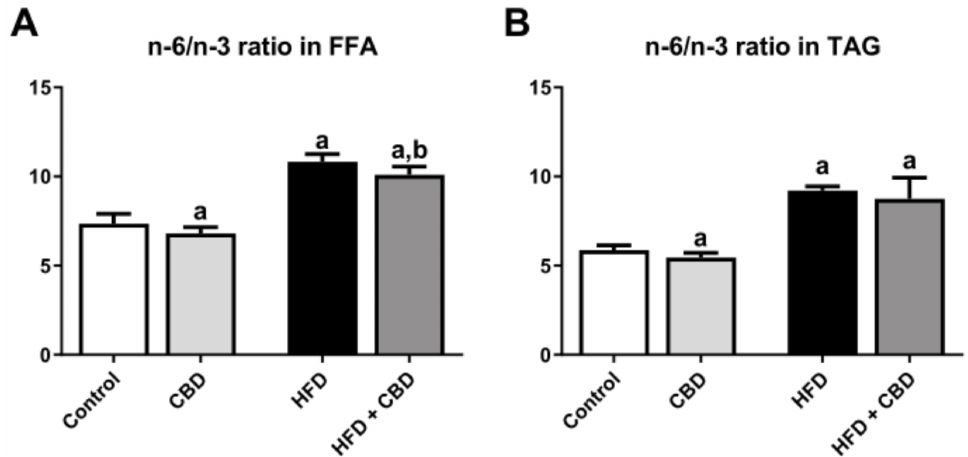
Figure 2. Plasma n-6/n-3 PUFA ratio in the ( A ) free fatty acid (FFA) and ( B ) triacylglycerol (TAG) fractions in the control (standard diet) and high-fat diet (HFD) groups after two-week cannabidiol (CBD) treatment. The data are expressed as mean values ± SD, n = 10 in each group. a p < 0.05 indicates a significant difference: the control group vs. the examined group; b p < 0.05 indicates a significant difference: HFD vs. HFD +